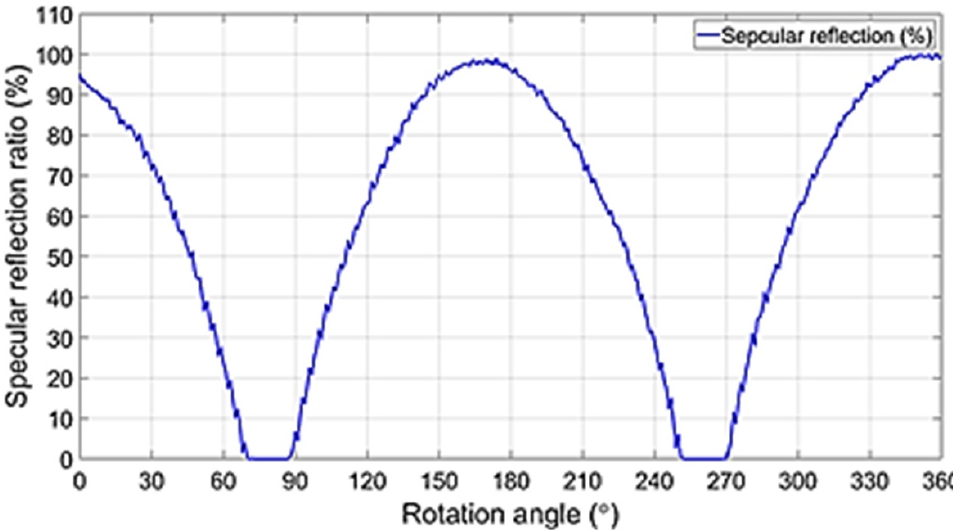
Figure 7. Changes in light reflection intensity according to the rotation axis of the filter using Malus’s laws.